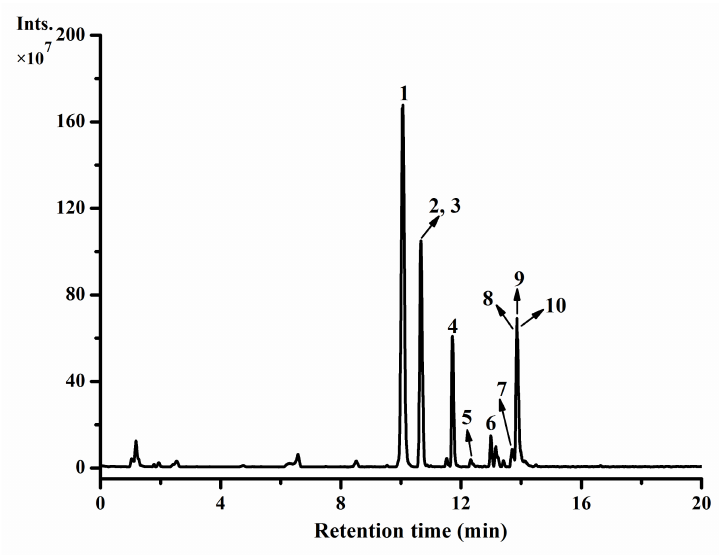
Figure 1. Negative ion current chromatogram of hot-water extract from vine tea ( Ampelopsis grossedentata ): Peaks identification and their MS data are shown in Table 1. Peak 1, dihydromyricetin; peak 2, iso-dihydromyricetin; peak 3, myricetin-3- O -glucoside; peak 4, myricetin-3- O -rhamnoside; peak 5, quercetin-3- O -xyloside; peak 6, quercetin-3- O -rhamnoside; peak 7, quercetin; peak 8, phloridzin; peak 9, phloretin; and peak 10,